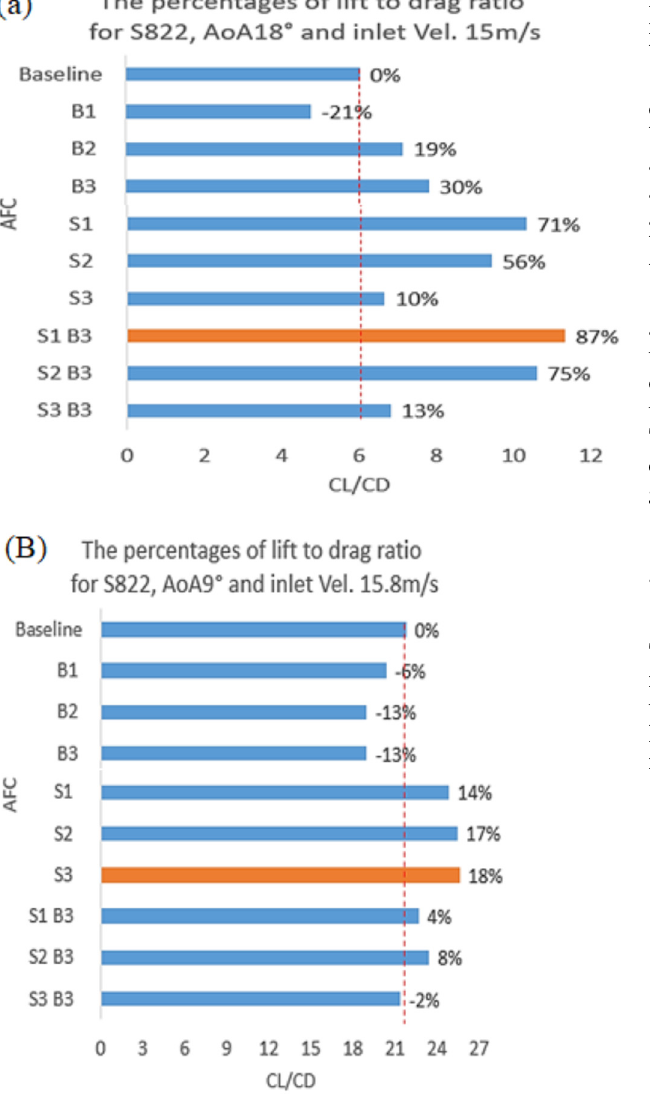
Fig. 8. The percentages of lift-to-drag ratios CL/CD [dimen- sionless] for S822 with AFC methods: (a) for AoA of 18 ° ; (b) for AoA of 9 °